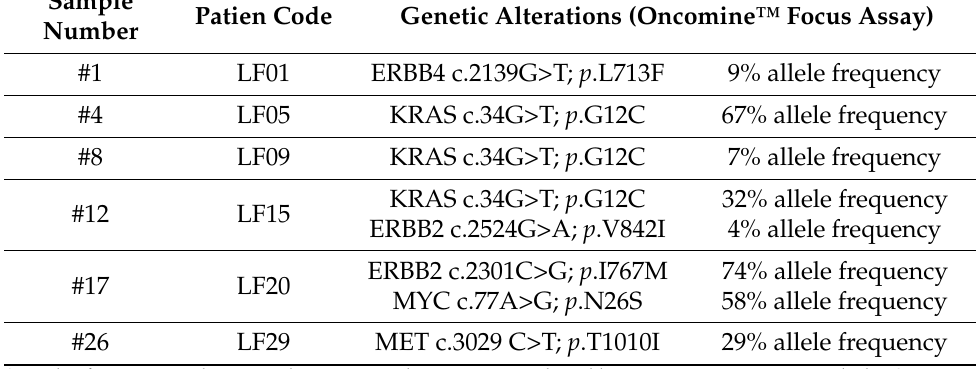
Table 3. Somatic mutation in surgically resected tumors that generated